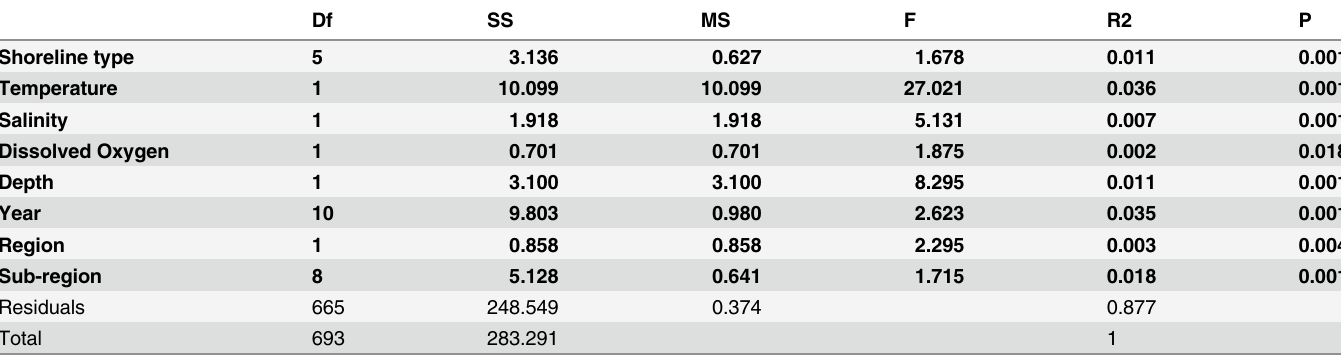
Table 2. Results of PERMANOVA analysis of fish community structure.